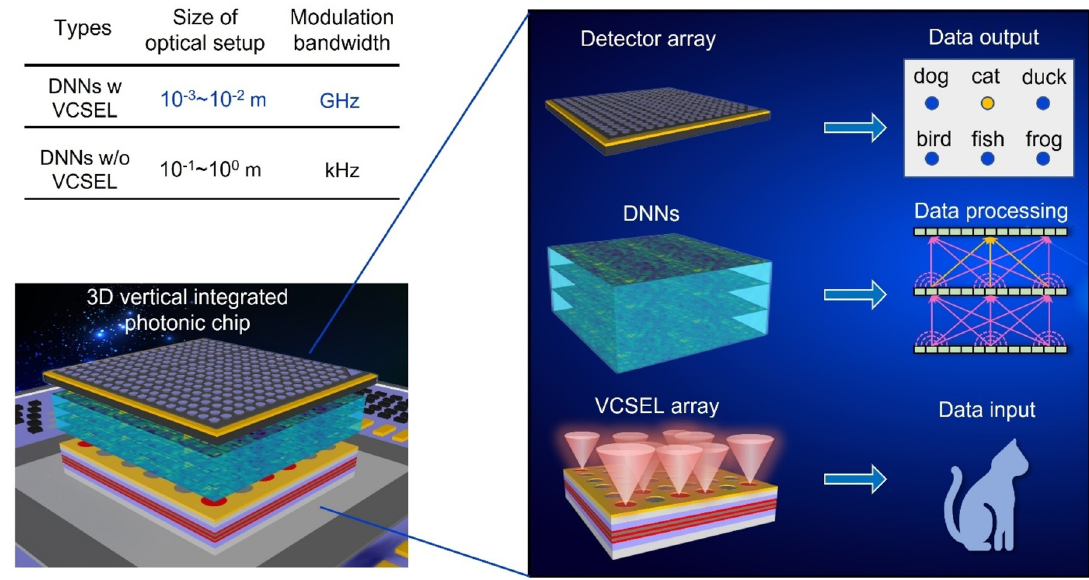
Figure 1: The on-chip integration design of DNNs based on VCSEL